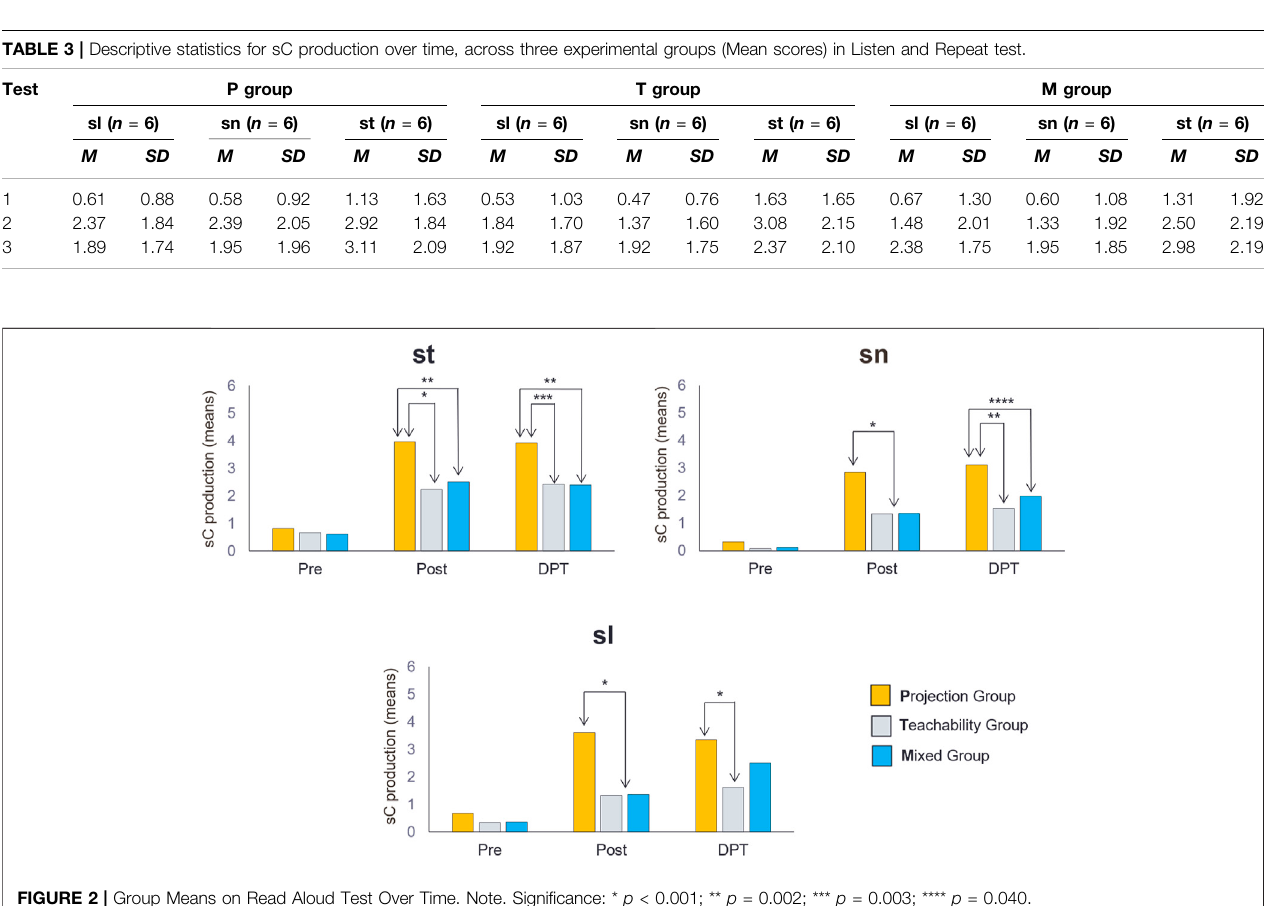
Frontiers in Communication |